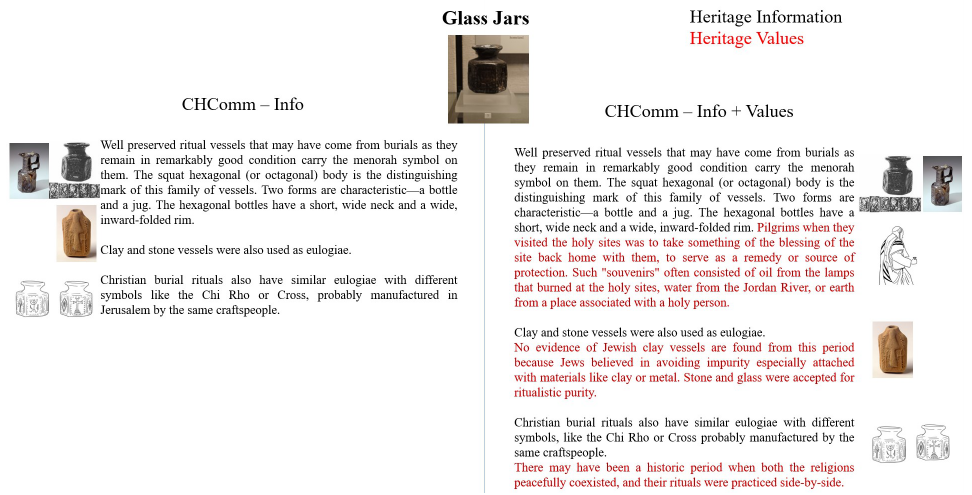
Figure 12. Comparative slide showing the differences between the script for voice-over and the additional illustrations in the videos made as part of the CHComm Info and the CHComm Info + Values applications for the ‘Glass Jar’